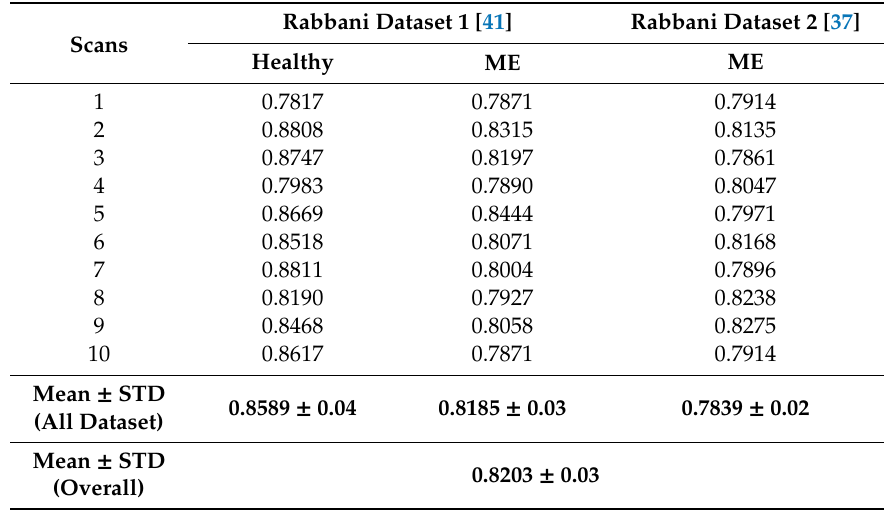
Table 7. Mean dice coe ffi cient for blood vessels segmentation against a local clinician’s annotations.